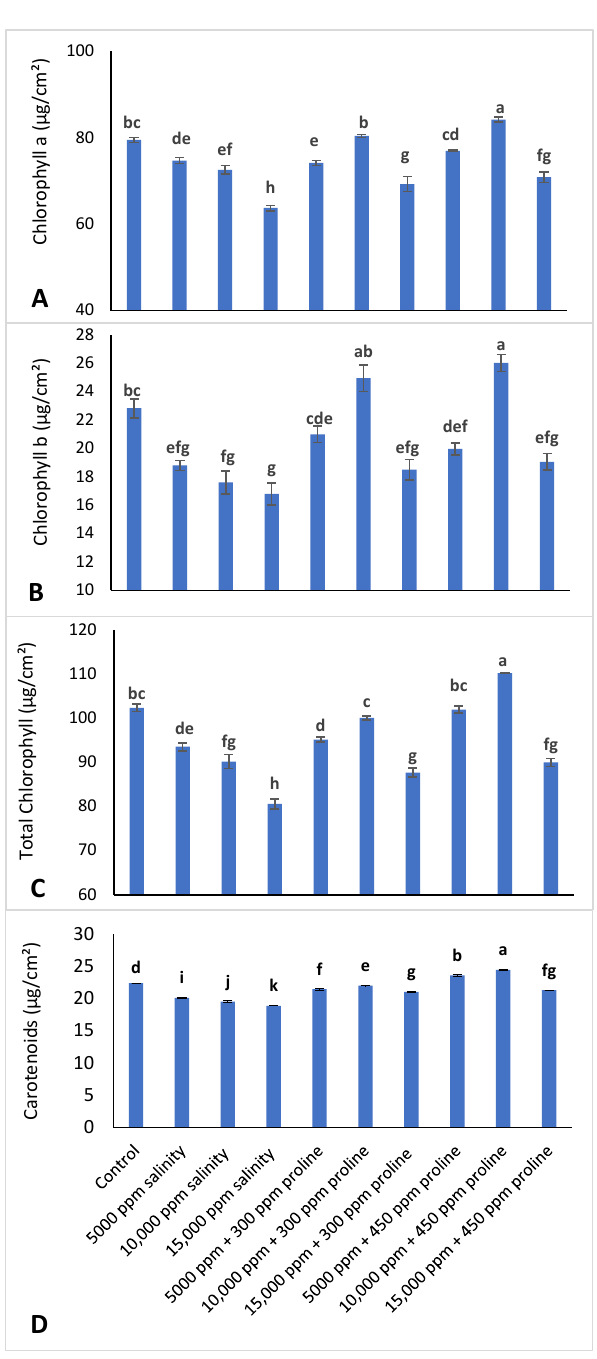
Figure 5. Effect of different levels of seawater salinity and exogenous proline at three concentrations, 0 ppm, 300 ppm, and 450 ppm, on ( A ) chlorophyll a ( μ g/cm 2 ), ( B ) chlorophyll b ( μ g/cm 2 ), ( C ) total chlorophyll ( μ g/cm 2 ), ( D ) and carotenoids ( μ g/cm 2 ). Data are means of two seasons (2020 and 2021) and three replicates ( n = 3) each season. The mean values ± SE of each parameter followed by different alphabetical letters are significantly different according to Duncan’s multiple range test at p ≤